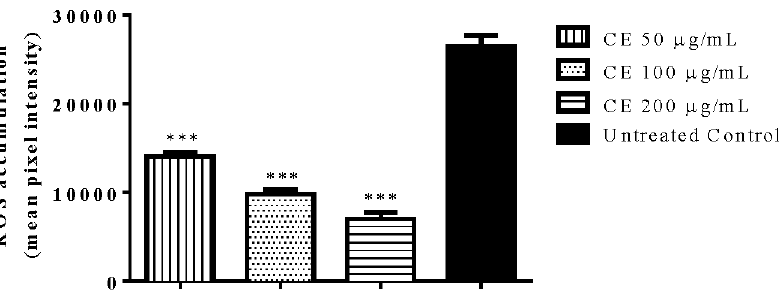
Figure 3. Quantification of intracellular ROS in N2 worms using DCFDA. Worms treated with C. spruceanum extract (CE) showed lower levels of ROS compared to the control group. Data are presented as mean pixel intensity ± SEM ( n = 40, replicated 3 times). *** p < 0.001, compared to the untreated control by one-way ANOVA followed by Bonferroni (post-hoc).